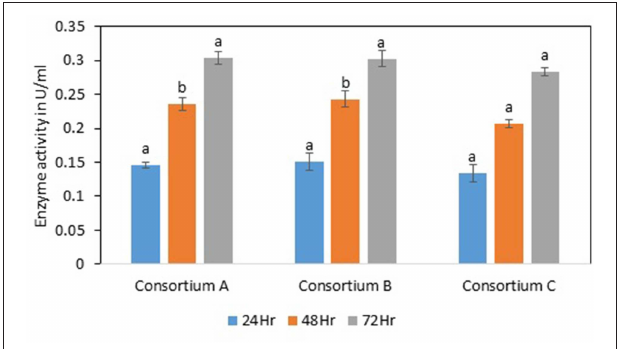
FIGURE 7 | Total cellulase activity of different consortia. Values are the mean ± SE (standard error). Mean values in each bar with the same alphabet superscript(s) do not differ significantly, but different alphabet superscript is showed significantly different between each treatment by Duncan post hoc test ( p ≤ 0.05).